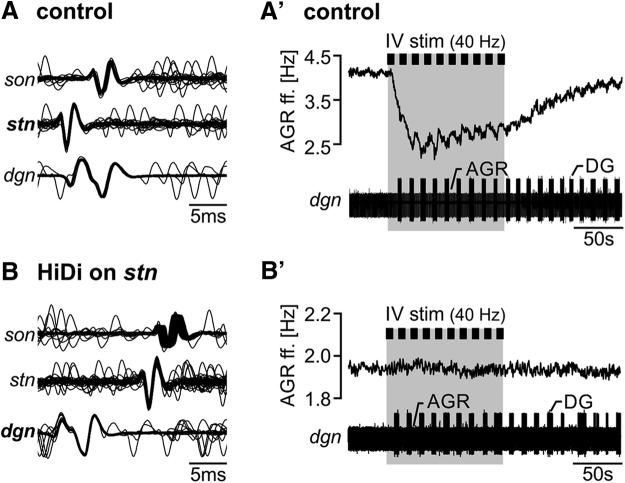
IV neurons only influence AGR when APs are generated ectopically in the stn. A, B, Overlay of multiple AGR APs (72 APs each) for (A) control condition and (B) during HiDi application. Data are from the same preparation. Bold highlighted nerve names mark the recording site where APs appeared first. APs on the dgn were used for temporal alignment. A’, B’, Example recording showing AGR ff. before and during IV neuron stimulation for (A’) control condition and (B’) during HiDi application to the stn. Extracellular recordings of the dgn (bottom) show the gastric mill rhythm (rhythmic firing of DG). Data from the same preparation as shown in A, B.